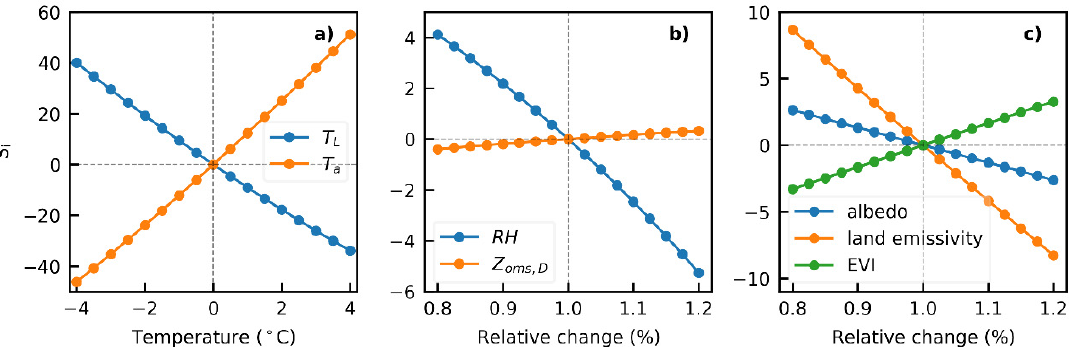
Figure 7. Relative changes caused by input variables for the WAPT model: ( a ) land surface temperature and air temperature; ( b ) relative humidity and z oms,D ; ( c ) albedo, land emissivity and EVI.